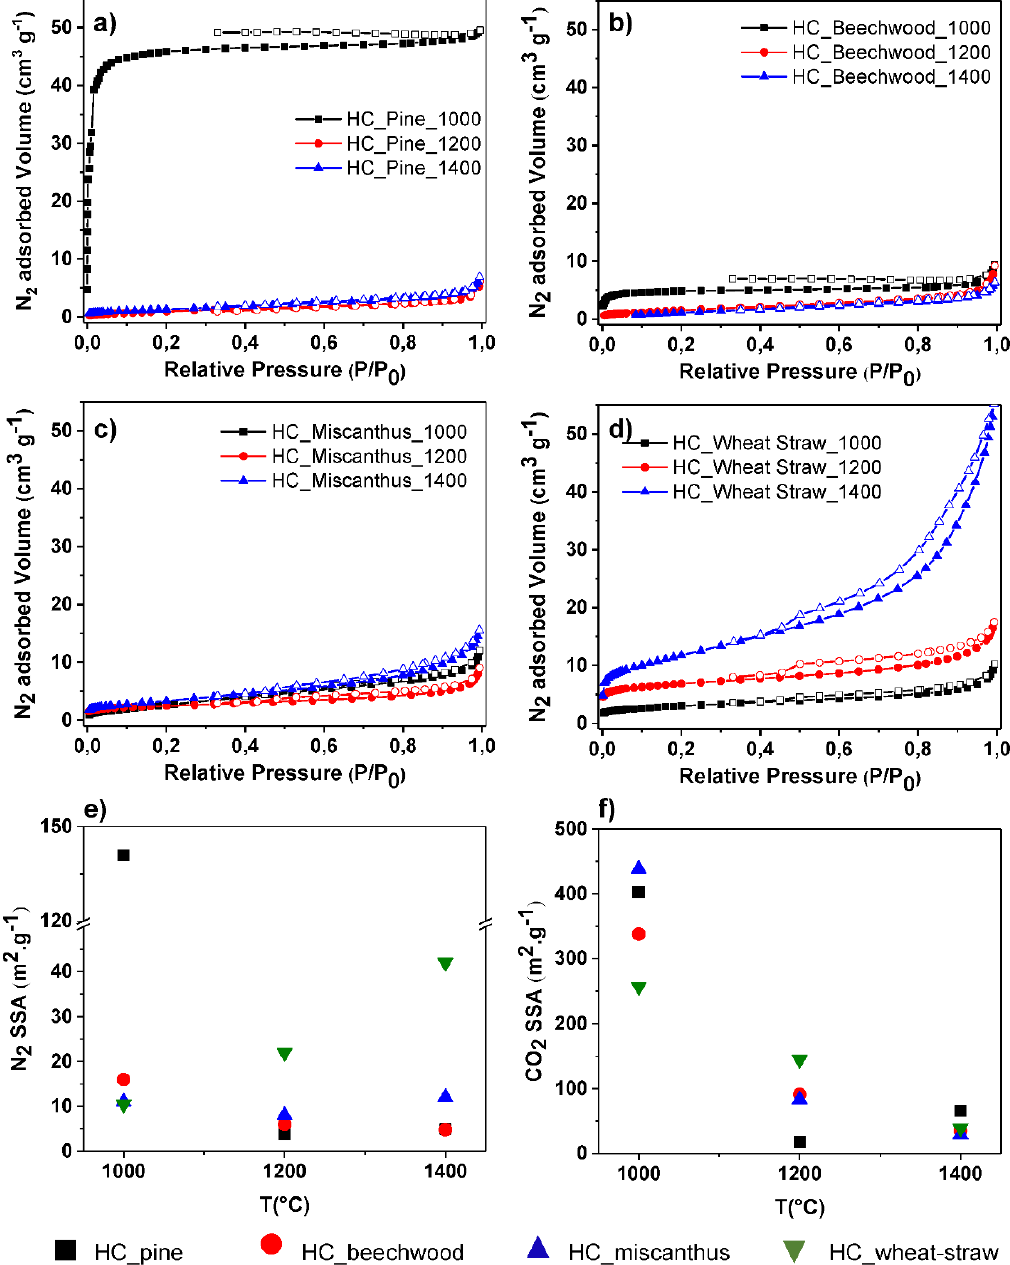
Figure 6. N 2 adsorption / desorption isotherms for ( a ) pine, ( b ) beechwood, ( c ) miscanthus and ( d ) wheat straw derived hard carbons. ( e ) N 2 and ( f ) CO 2 specific surface area (SSA) variation with temperature for all the hard carbons.